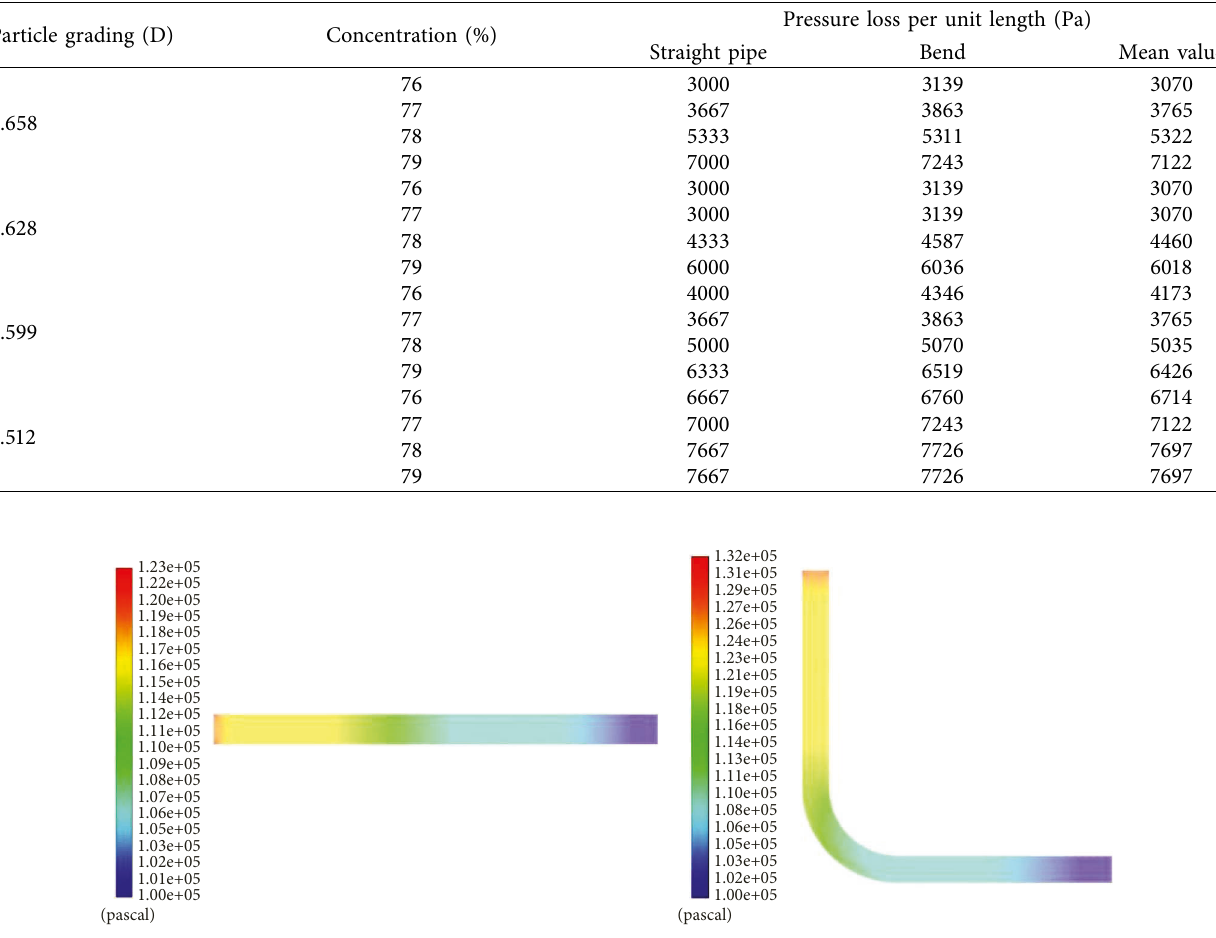
Figure 10: Numerical simulation diagram of slurry with a concentration of 79% and fractal dimension of